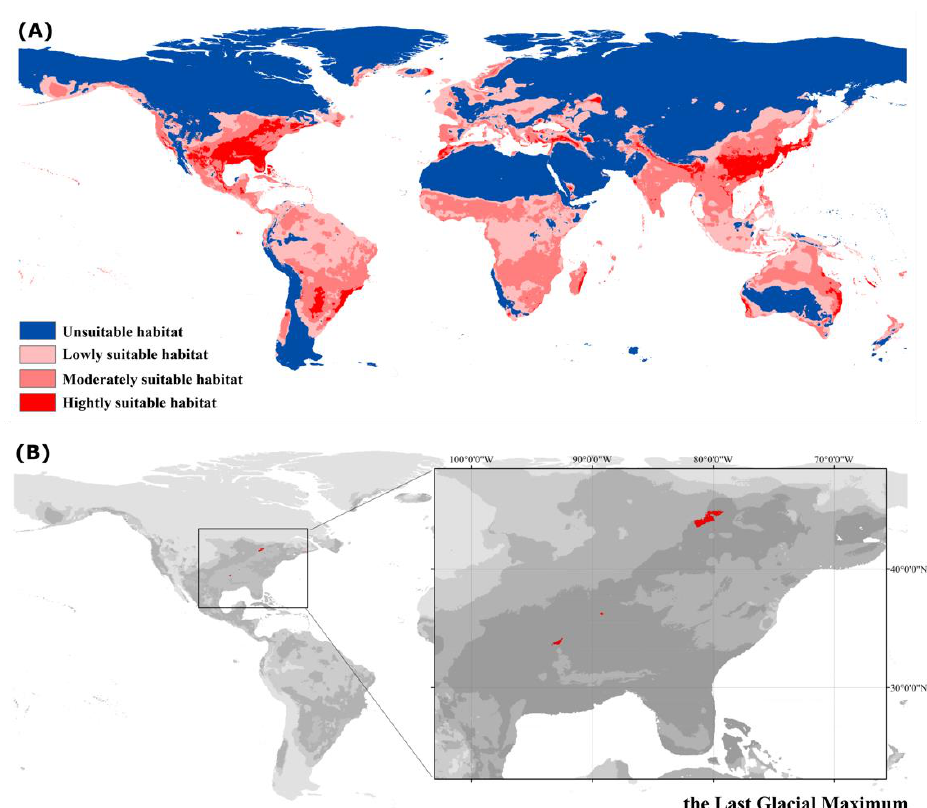
Figure 5. Modeling of suitable habitat distribution ( A ) and refugia ( B ) of P. flavescens in historical period: the Last Glacial Maximum. Light gray to dark gray represents an increase in habitat suitability, and red represents the location of refugia.